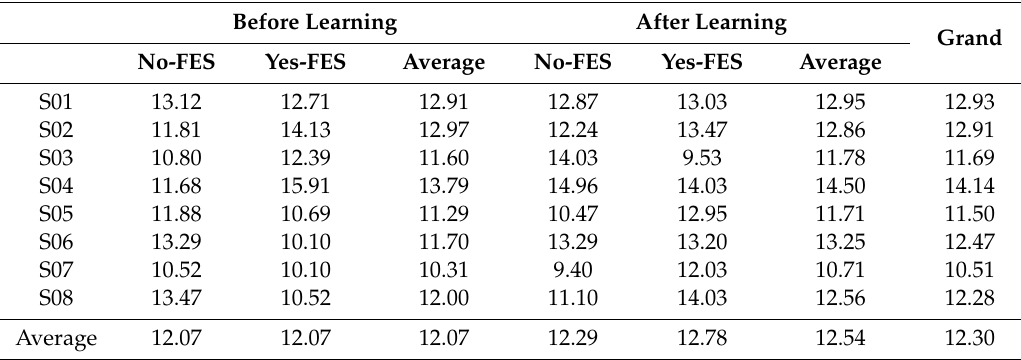
Table 6. Information Transfer Rate (ITR) for each IV (bit /